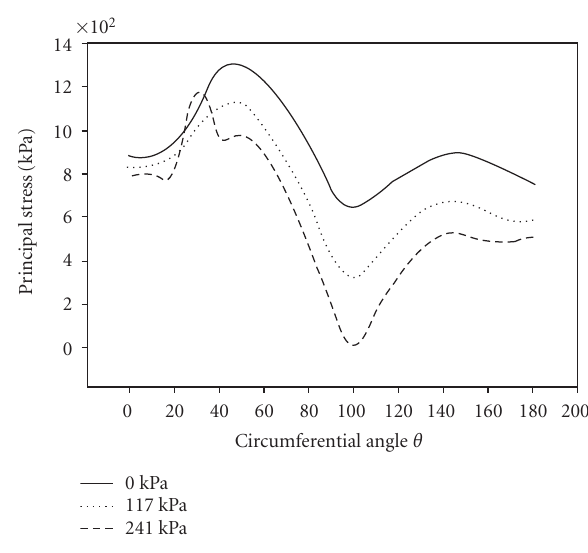
Figure 11: Influence of inflation pressure on the maximum princi- pal stress at the outer pad.